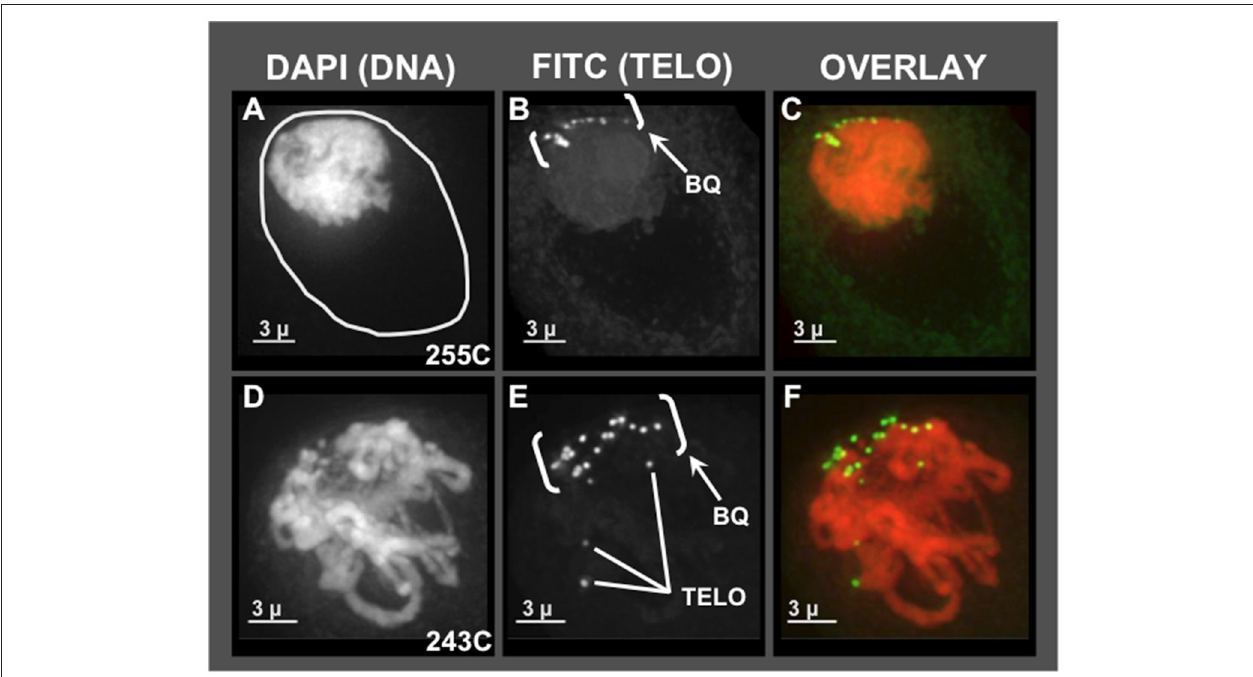
FIGURE 1 | Telomere bouquet in pollen mother cells of hop. Male flower buds were harvested and fixed in Farmer’s Fluid, then exchanged into Buffer A and formaldehyde fixed before microdissecting pollen mother cells from anthers for 3D acrylamide FISH. Through-focus projections of nuclei, one nucleus per row, are shown as through-focus maximum-intensity projections in gray-scale for individual wavelengths or in color for overlay images, as labeled across the top. (A–C) Hop nucleus from plant 255C at early prophase showing the nuclear periphery ( A - white circle) and the telomere cluster region (bracketed, BQ). (D–F) Hop nucleus from plant 243C at early-middle prophase showing the bouquet (BQ), with three examples of single telomere FISH signals (Tel, E )